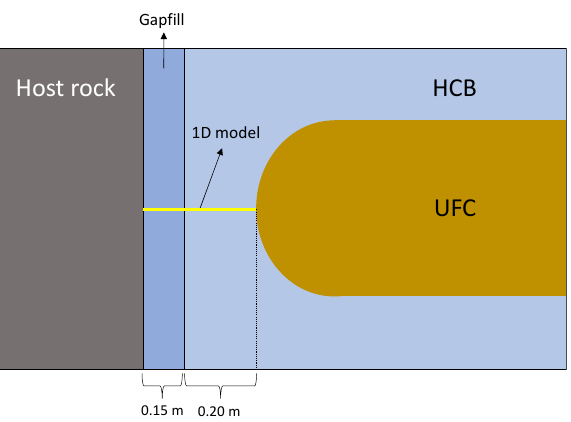
Figure 1. Diagram of a section of the used fuel containers (UFC) inside the placement room, the yellow line shows the one-dimensional model.